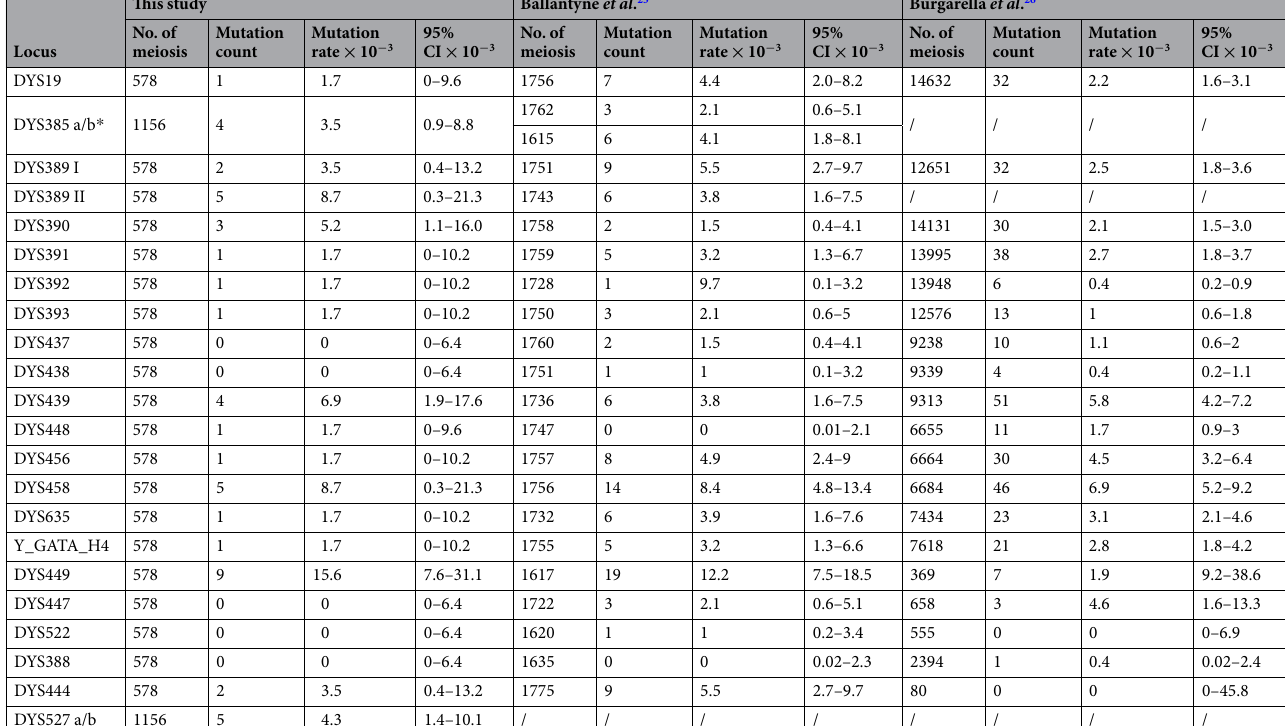
Table 4. Comparison between the mutation rates of this study and other two published studies with large number of meiosis. * The mutation rate for DYS385 a/b was calculated separatly as DYS385 a and DYS385 b by Ballantyne’s study. / The data were absent due to these loci were not included in the